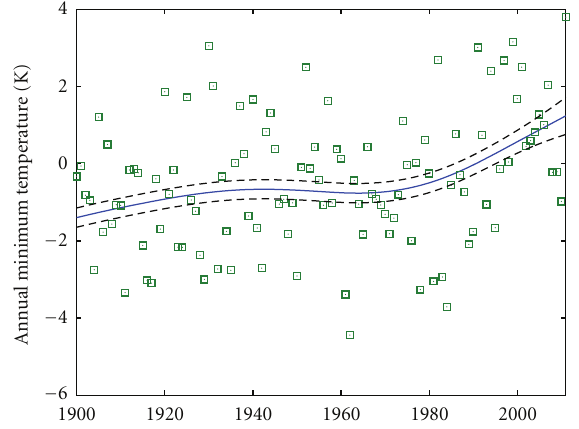
Figure 4: Annual minimum temperature anomaly (relative to the 1976–2005 mean) averaged across the coterminous USA, along with a fitted trend curve. Dashed curves show a 1- σ uncertainty envelope for the trend.